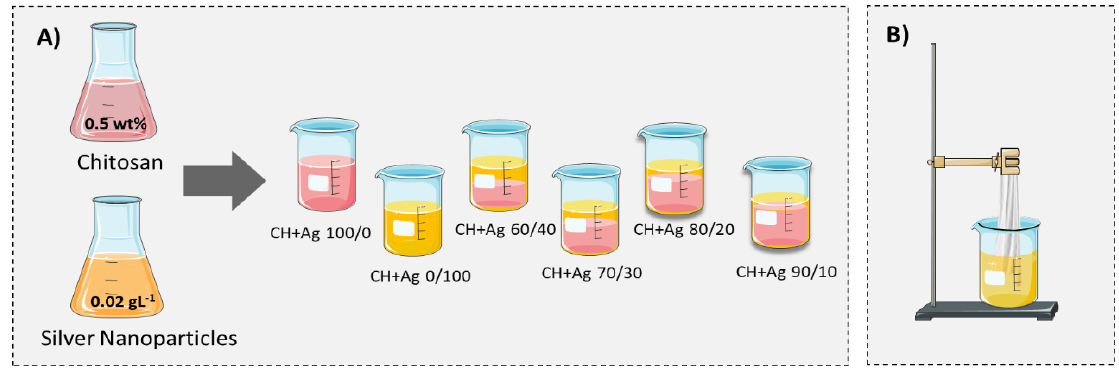
Figure 1. Schematic representation of ( A ) the solutions for coating the nylon fabric; dilutions were made with the mother solution of chitosan (CH) and silver nanoparticles (Ag), and ( B ) dip-coating method used for the coating. The dilutions are represented as the percentage of chitosan and silver (CH/Ag).